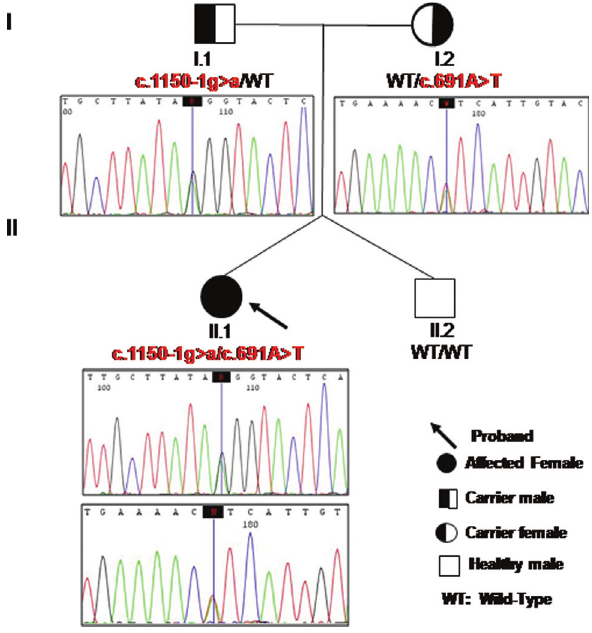
Figure 3 - Pedigree of the patient with MCC deficiency. Sequence elec- tropherograms of exon 7 and intron 12/exon 13 boundary of the MCCC2 gene are shown for the patient and her